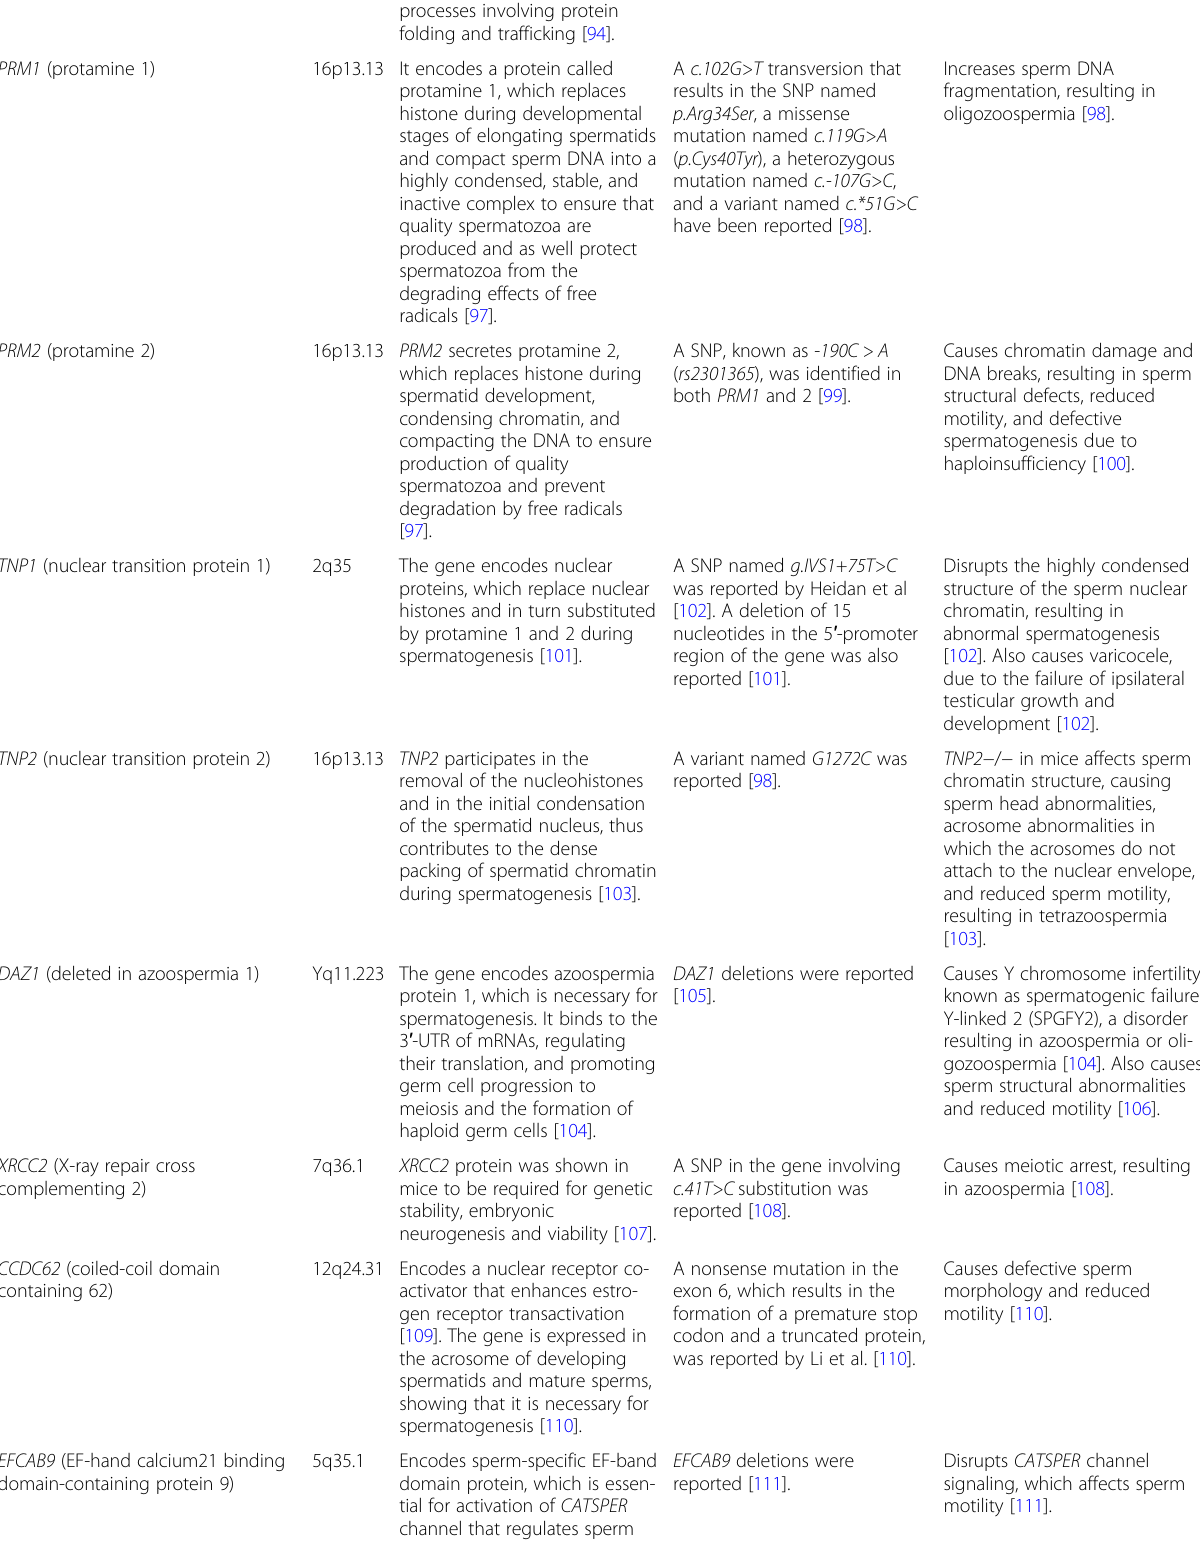
Table 2 Genes predisposing to nonsyndromic spermatogenic failure and sperm morphological abnormalities (Continued) processes involving protein folding and trafficking